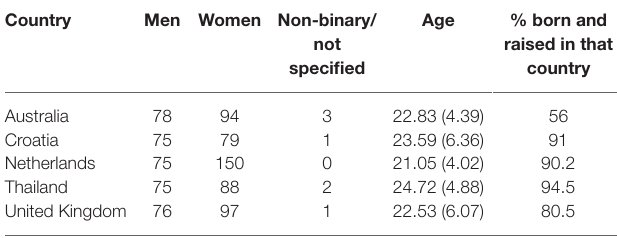
TABLE 1 | Participant demographics for each country, including number of participants by gender, mean (SD) age in years, and the percentage of participants who indicated they were born and raised in that